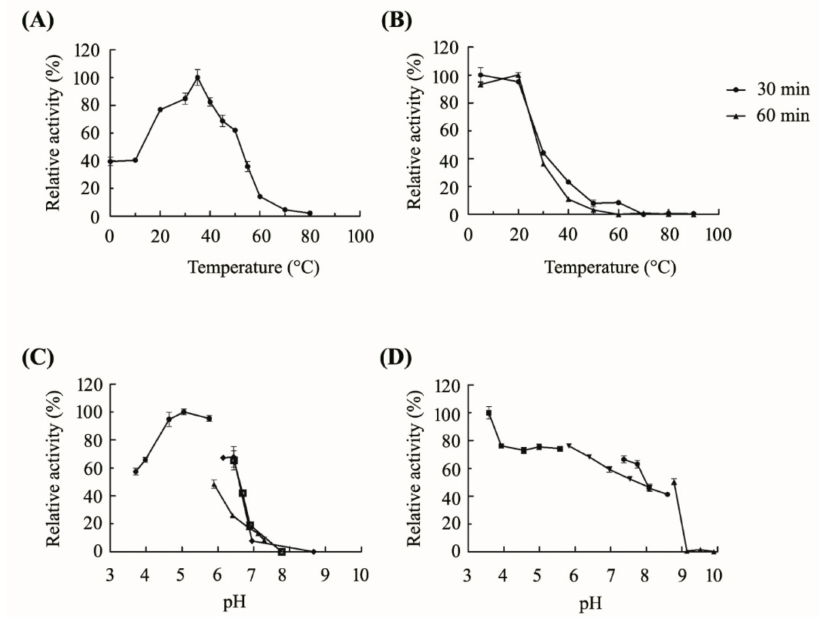
Figure 4. E ff ect of temperature and pH on CsnB activity. ( A ) E ff ect of temperature on the activity of chitosanase. ( B ) Thermo-stability of CsnB. Two groups of enzymes were incubated for 30 min or 60 min. ( C ) E ff ect of pH on the activity of chitosanase. (HAC-NaAC bu ff er, pH 3.71-5.76; phosphate bu ff er, pH 5.89-7.29; Tris-HCl bu ff er, pH 6.45-7.78; glycine-NaOH bu ff er, pH 6.15-8.67.) ( D ) pH-stability of CsnB. The pH-stability was analyzed by measuring the residual activity after pretreating the enzyme in di ff erent bu ff ers at 4 ◦ C for 24 h (HAC-NaAC bu ff er, pH 3.58-5.58; phosphate bu ff er, pH 6.97–8.10; Tris-HCl bu ff er, pH 7.37–8.60; glycine-NaOH bu ff er, pH 8.78-9.90). Values are the means of three independent experiments ± standard